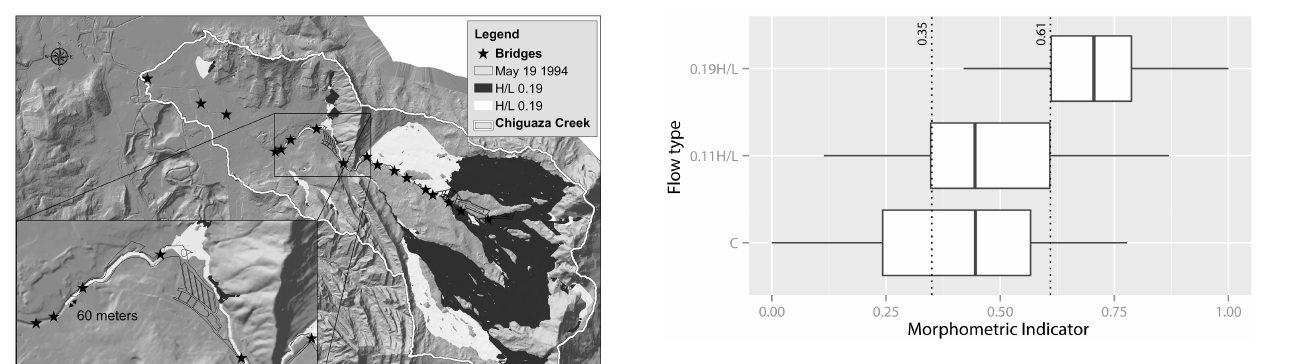
Figure 7. Morphometric indicator with values rescaled from 0 to